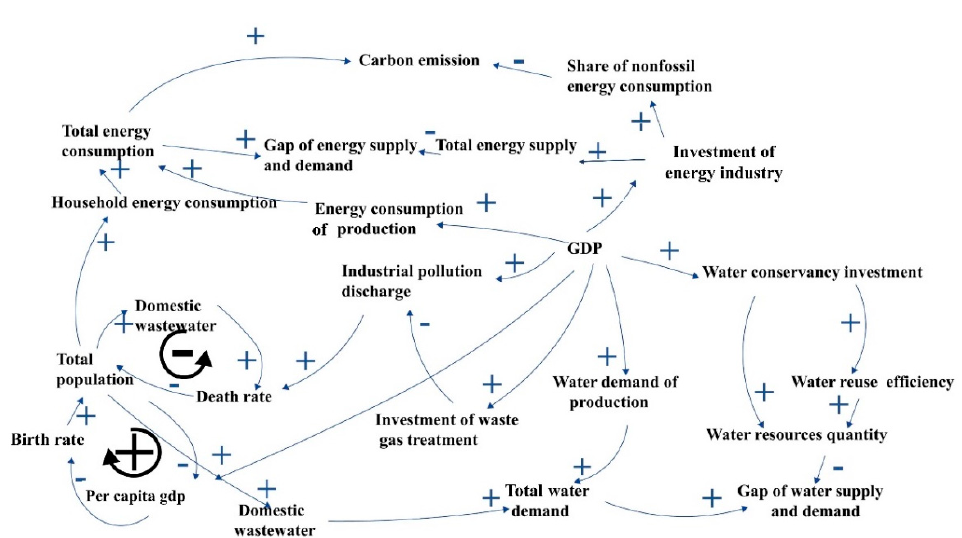
Figure 1. The Logical Framework of Causal Relationships in the Hebei Province Urban Metabolism Model.